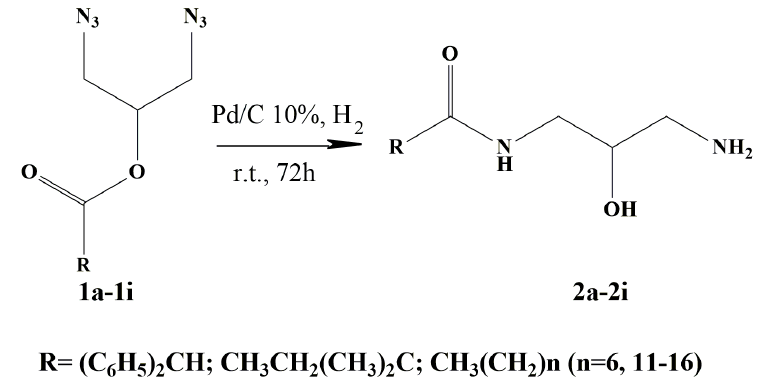
Figure 2. Scheme of the synthesis of monoamides 2a to 2i by hydrogenation of the corresponding diazides 1a to 1i.